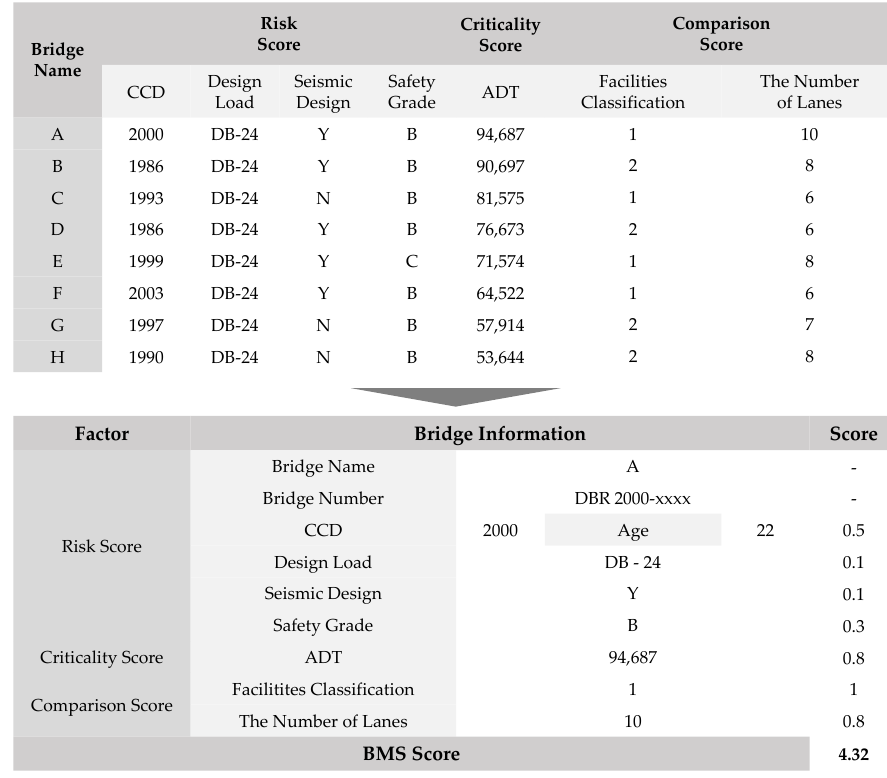
Figure 4. Examples of data input into Excel to help prioritize bridge maintenance. Table 7. Maintenance priority selection results.